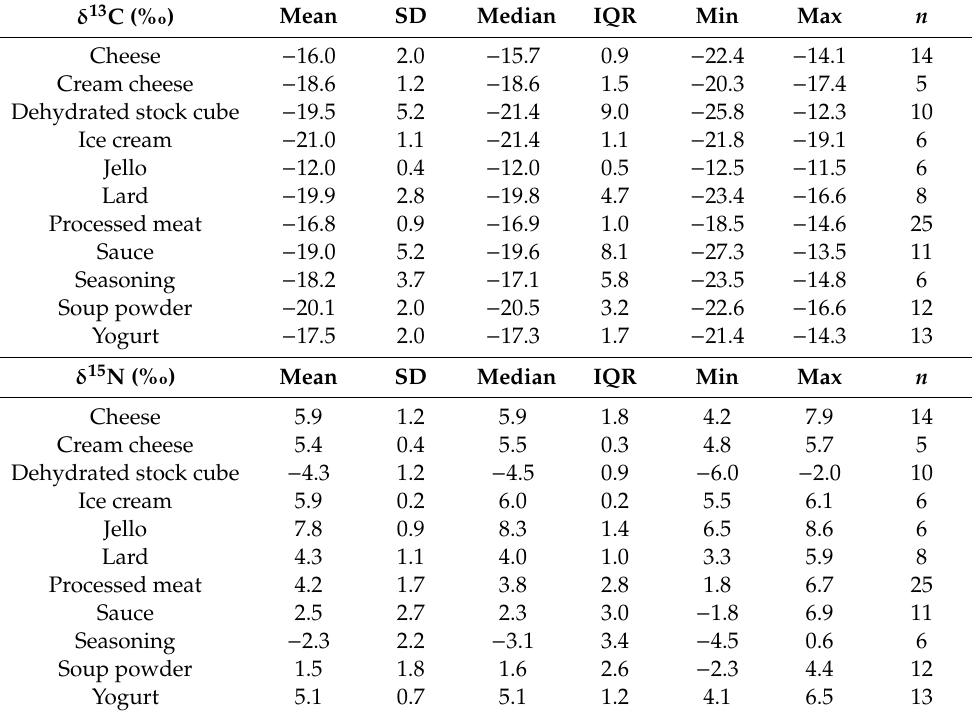
Table 2. Descriptive statistics* of δ 13 C and δ 15 N of animal-based processed foods.